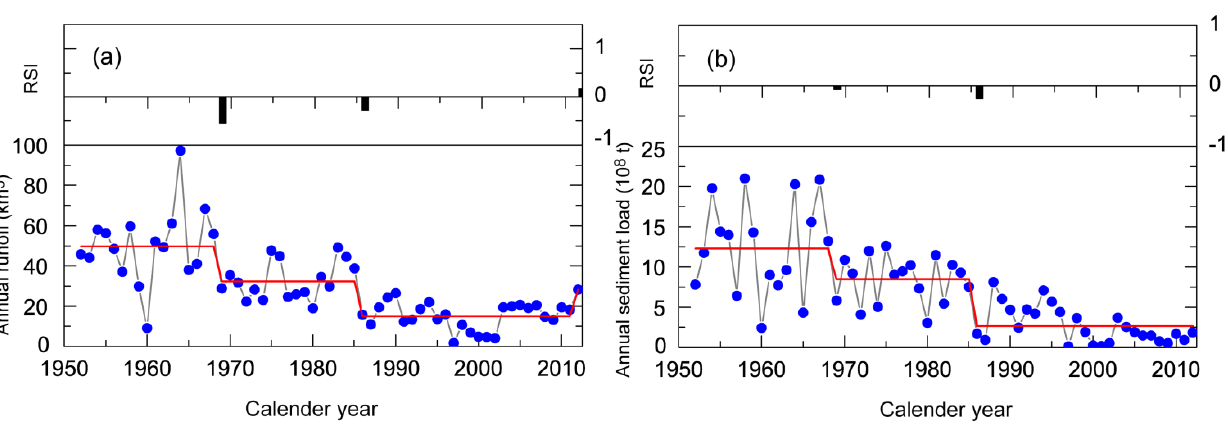
Figure 6. Regime shift detection in the annual runoff and sediment loads at the